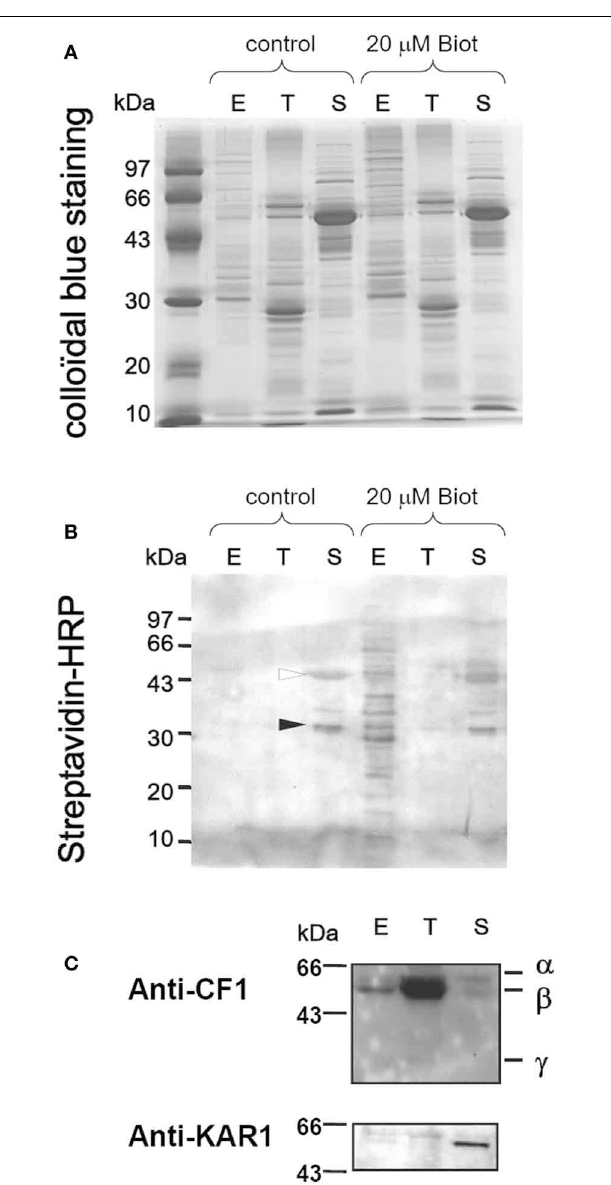
FIGURE 1 | Specific chloroplast envelope biotinylation. Proteins prepared from intact (control) or biotinylated (20 µ M Biot) spinach chloroplast sub-fractions (20 µ g) were separated by 1D-PAGE. Polypeptides were either stained with Coomassie brilliant blue G- 250 (A) or electro-transferred to nitrocellulose membranes (B,C) . (B) Biotin was detected after reaction with streptavidin coupled to horse-radish peroxidase (HRP). Naturally biotinylated proteins from the stroma are indicated in control conditions (black and white arrows, see text). (C) Western blot detection of the CF1 ATPase α , β , and γ subunits from thylakoids (anti-CF1 1/10.000) and of the ketol-acid reductoisomerase from the stroma (anti-KARI 1/5000). E, envelope; T, thylakoids; S, stroma.